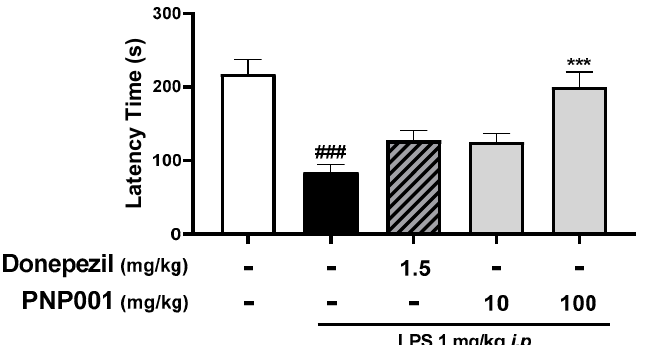
Figure 6. Effect of PNP001 on the memory dysfunction in LPS-injected mice. Mice were administered with PNP001 (10 or 100 mg/kg, p.o. ) and DNZ (1.5 mg/kg, p.o. ) for 18 consecutive days, and LPS (1 mg/kg, i.p. ) was administered concurrently for 10 days from the 4th day of PNP001 administration. The step-through passive avoidance test (PAT) was performed to evaluate the effect on long-term memory function by measuring the latency time to escape the bright chamber. Values are indicated as the mean ± S.E.M. Data were analyzed using two-way ANOVA followed by Tukey’s multiple comparisons test. ### p < 0.001 compared to the control group; *** p < 0.001 compared to the LPS-only-injected group.